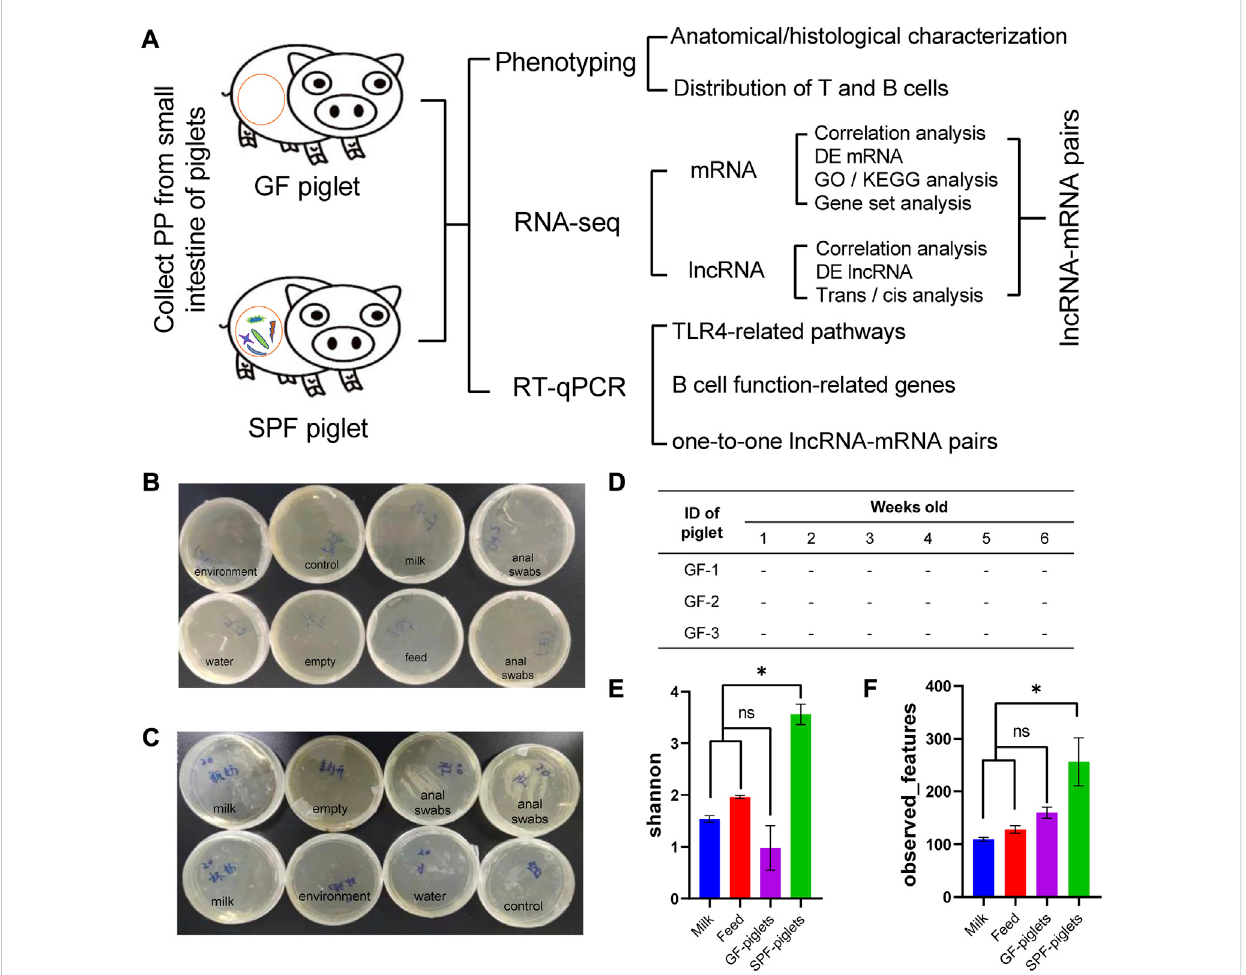
FIGURE 1 Schematic illustration of this study and the microbiota detection protocol. (A) Flow chart of PP phenotype and RNA-seq analyses. Medium samples were used to detect microbiota in the feeding isolator, including in the environment, feed, milk powder, and piglet anal swabs [Normal (B) and abnormal (C) detection]. (D) GFpiglets remainedsterileduring theexperiment(tested onceaweek). (E,F) Microbiota detection infeed, milk powder, andpiglet anal swabs by 16s rDNA amplicon sequencing. Shannon and observed features indices re fl ect the α diversity of the microbiota. n =